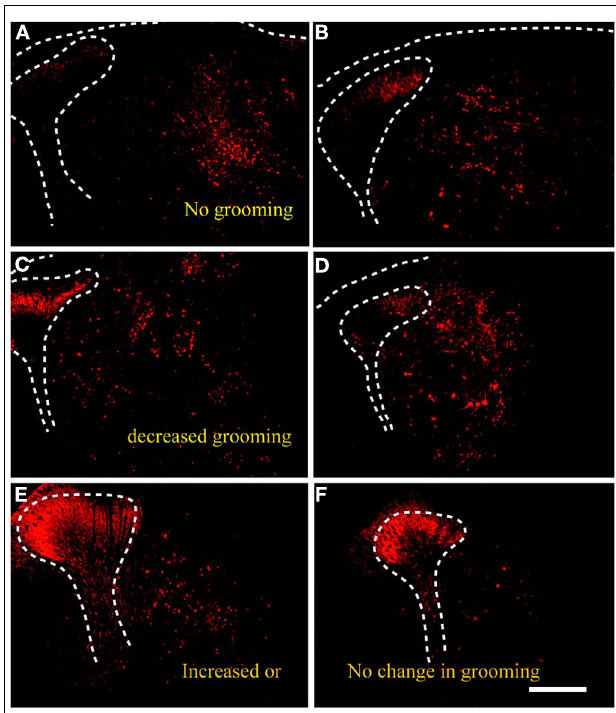
FIGURE 7 |Transplanted predifferentiated GABA-IR NPCs were visible in the spinal cord of QUIS animals three weeks after transplantation, and showed varying densities in the host spinal cord. Animals that stopped overgrooming [healed; (A,B) ] or displayed reduction in overgrooming (C,D) exhibited large number of transplanted GABA-IR NPCs in the spinal gray matter. Animals that continued to groom contained very few number of surviving GABA-IR cells in the spinal cord (E,F) . Scale bars = 500 μ